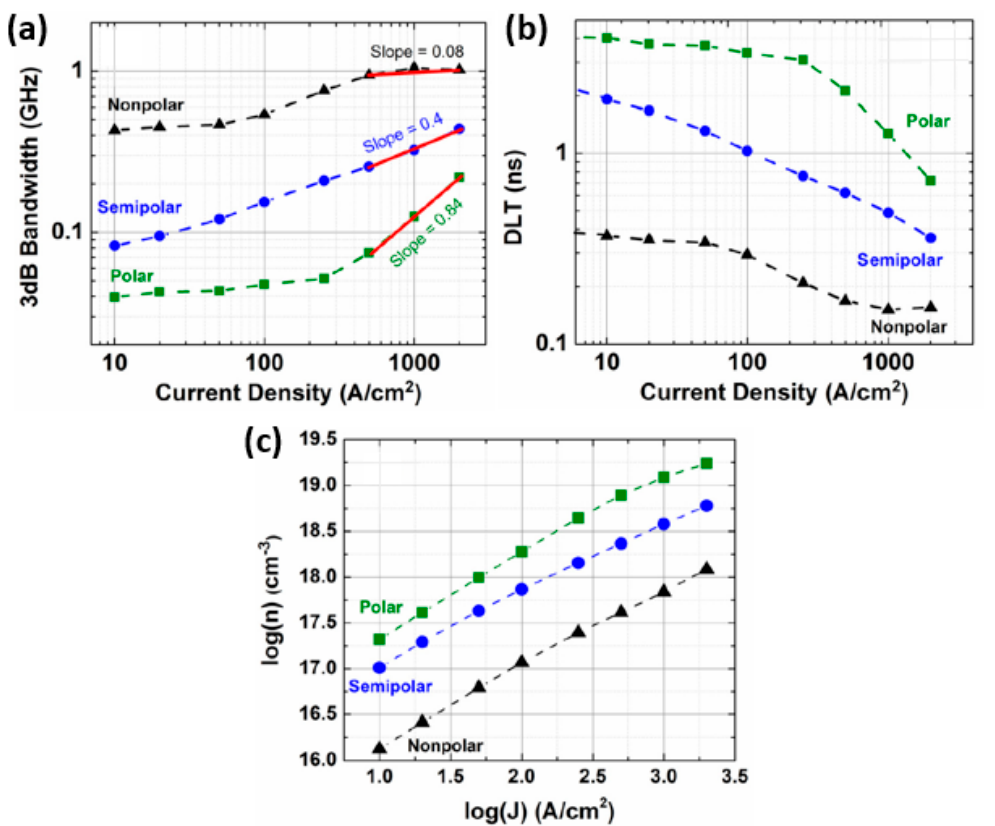
Figure 2. ( a ) Modulation bandwidth and ( b ) differential carrier lifetime as a function of current density and ( c ) calculated log (n) vs. log (J) for LEDs with polar (green squares), semipolar (blue circles), and nonpolar (black triangles) orientations. [51] Figures reproduced with permission from American Institute of Physics Publishing.